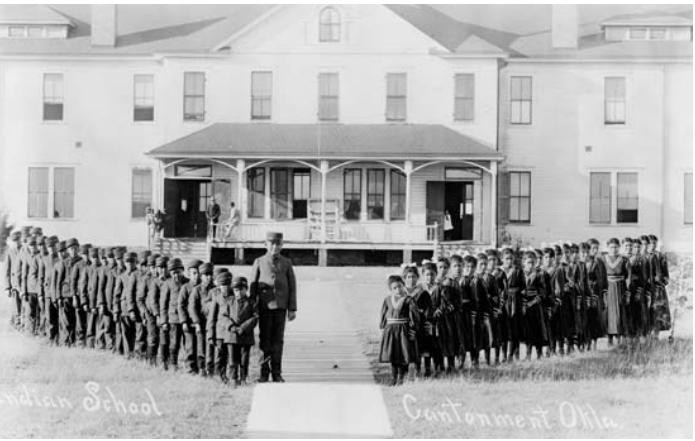
Figure 3. Indian boarding school at Cantonment, Oklahoma, ca. 1909. Library of Congress, Washington, D.C. (Neg. no. LC-USZ62-126134).